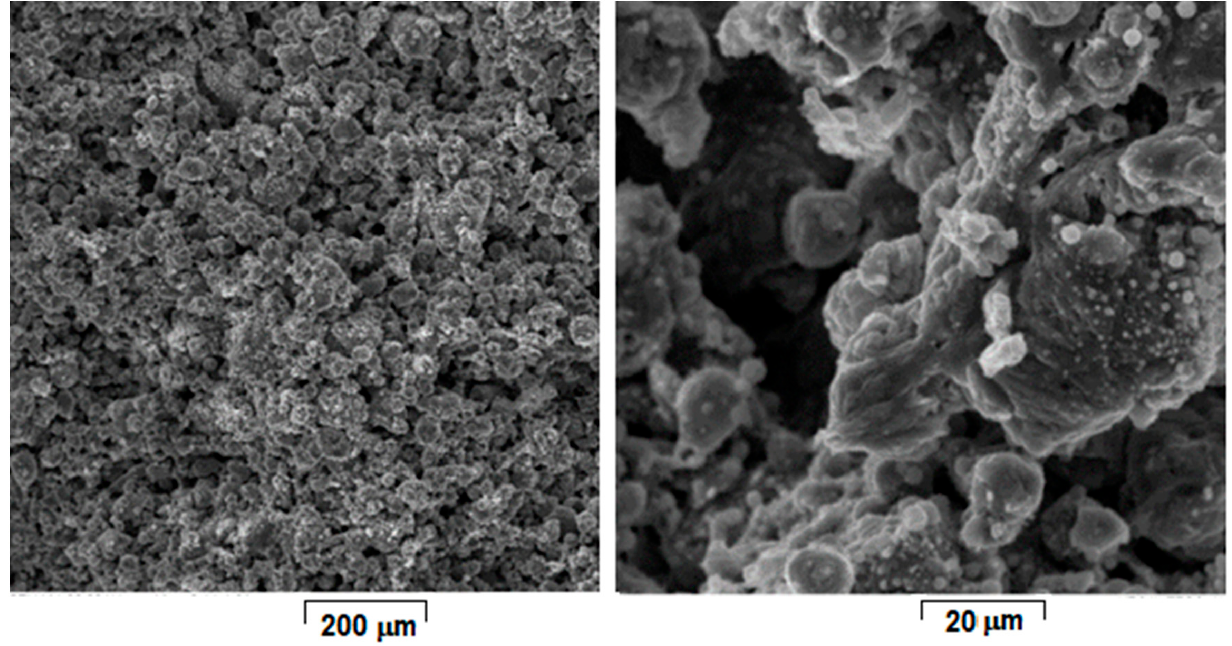
Figure 7. SEM-SE images of L-PBF sample obtained with laser power 175 W; scanning speed 700 mm/s; layer height 50 µ m applied parameters and calculated laser energy density 167 J/mm 3 .